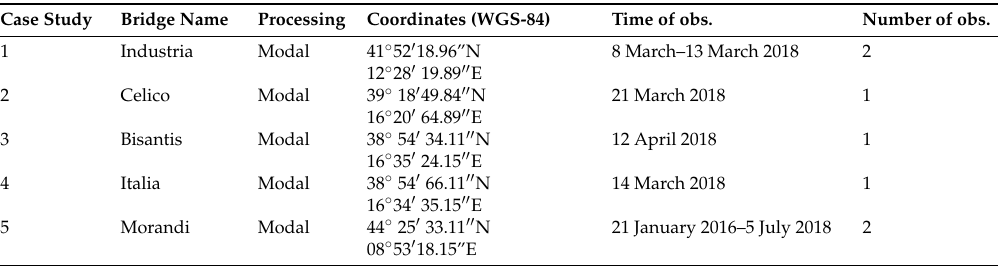
Table 2. List of data used for experimental